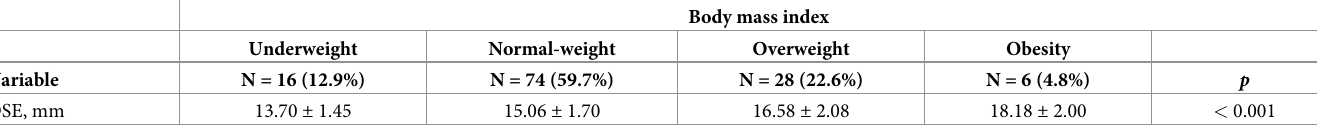
Table 2. Comparison of DSE between different body mass indices.